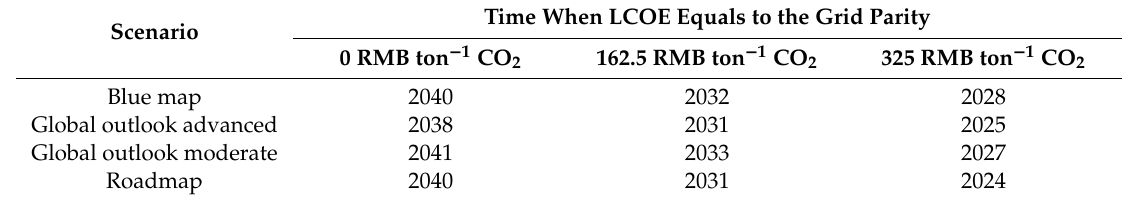
Table 7. Time when the grid parities of tower CSP systems would be achieved.